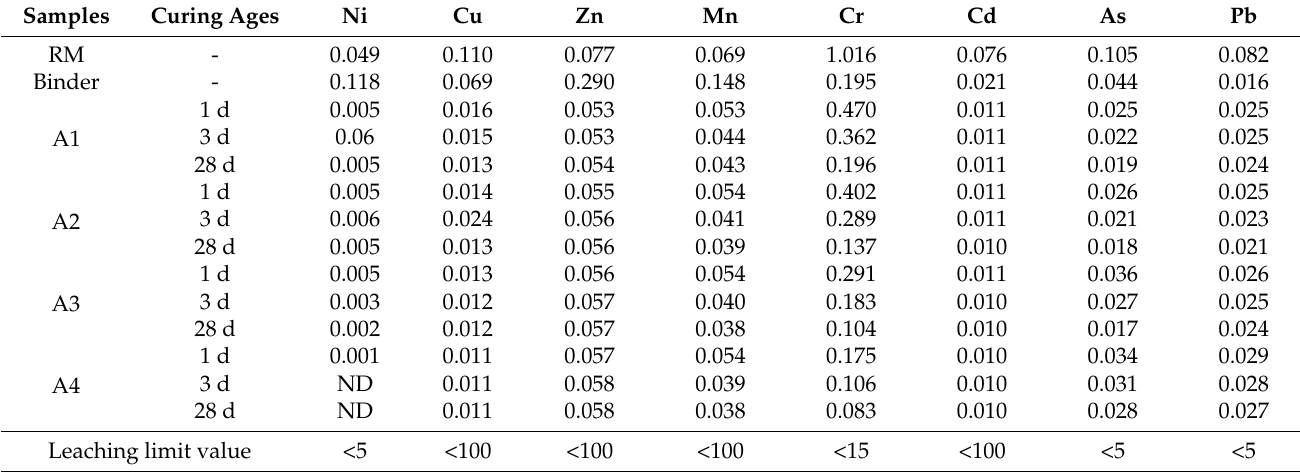
Table 8. Heavy metals leaching concentration of RM-based SFLAs at different curing ages (mg/L). Samples